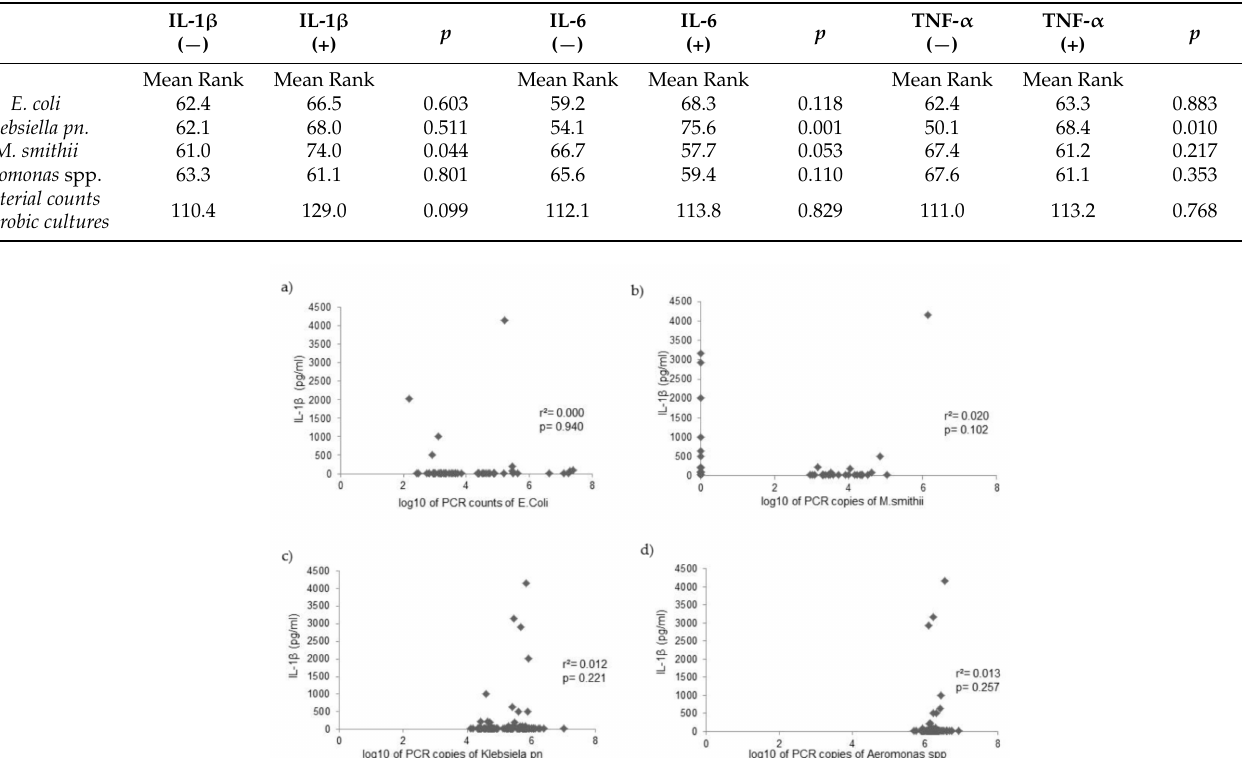
Figure 1. Prevalence of SIBO (using ≥ 10 3 cfu/mL as a cut-off) (blue bars) and IBS (green bars) among patients with 0, 1, 2, and 3 elevated cytokine levels (TNF- α , IL-6, and IL-1 β ) detected in the duodenal fluid. Patients with all 3 cytokine levels elevated have OR 3.47 (1.06–11.34, p = 0.03) presenting with SIBO. Table 4. Linkage between elevated cytokine levels and PCR copies of bacterial species, and bacterial counts in aerobic cultures, using Mann–Whitney U test.